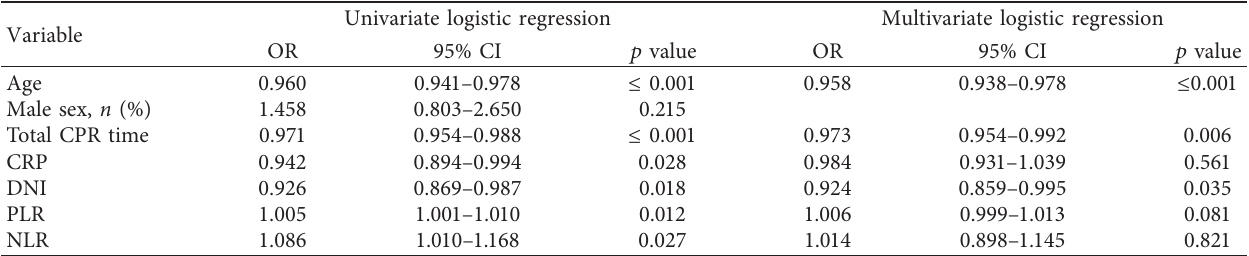
Table 3: The predictive factors for the secondary outcome (survival to discharge).